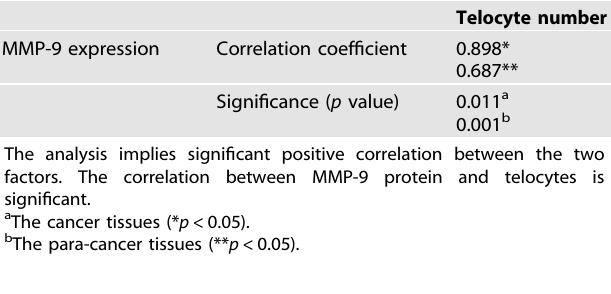
Fig. 2 Differences in telocyte and MMP9 expression between the hepatocellular cancer (HCC) and para-cancer tissues. A CD34-positive telocytes (red) in the HCC and para-cancer tissue (a, e). MMP9 expression in both tissues as determined by immunohistochemistry and immuno fl uorescence (b, c, f, g). Distribution of telocytes (CD34 + , green) and MMP9 (red) in the same paired tissue, and the relationship between them as determined by immuno fl uorescence (d, h). B Quanti fi ed telocyte count and MMP9 expression, and their statistical